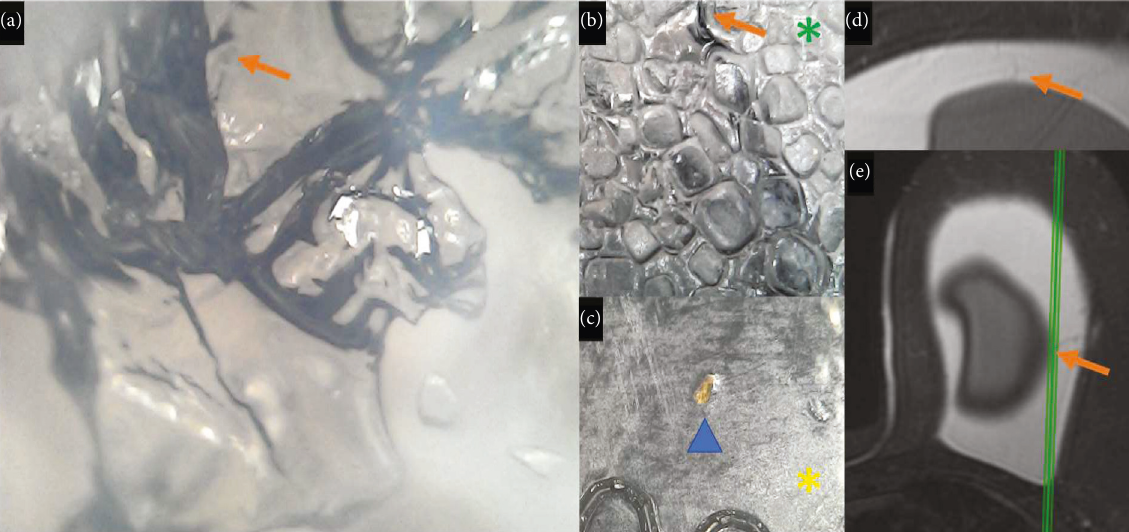
Figure 13: (a–e). Patients with textured breast implants with BIA-ALCL diagnosis presenting a sudden volumetric increase in the left breast. Microscopy shows neovascularization inside the implant in the orange arrow (a and b). The green arrow shows the pedicle in the textured surface (green asterisk), and in the smooth surface, there are fat infiltration (blue triangle) and surface degradation (yellow asterisk) in figure c (c). In the SPIR sequence, it is possible to see vascularization from the capsule to the implant (d and e) in the orange